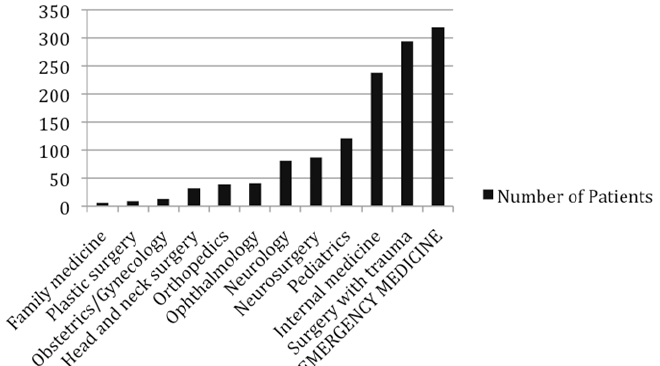
Figure 1. Number of higher level of care (HLOC) transfer patients per specialty for 12 specialties at one tertiary care site over 14 months. N=570 total patients billed 1280 times by specialty services.